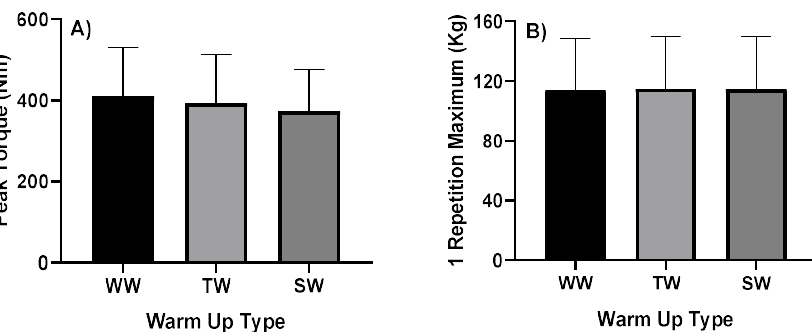
Figure 3. Evaluation of ( A ) peak torque (N.m) and ( B ) 1 repetition maximum (Kg), with different types of warm-up. WW: without warm-up, TW: traditional warm-up, and SW: stretching warm-up. No significant differences were found in relation to the (A) peak torque ( p = 0.055, F = 4.560, η 2p = 0.246 medium effect), and (B) 1 repetition maximum ( p = 0.139, F = 3.191, η 2p = 0.186, medium effect) between the different types of warm-up. Table 2. Skin temperature over active muscles in different types of warm-up (mean ± SD and CI 95%). Muscles